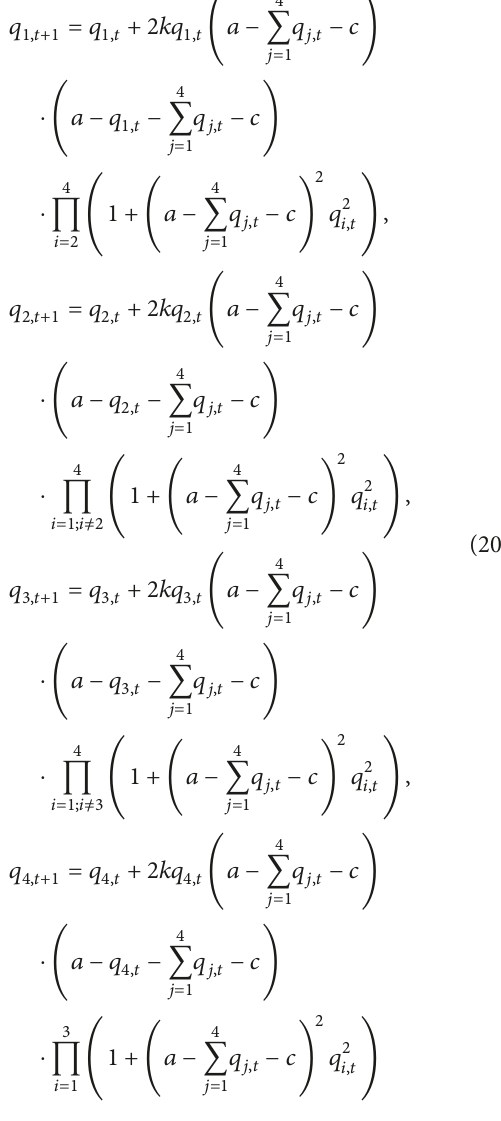
Figure 6: Bifurcation diagram of system (14) with respect to 𝑘 at (𝑎,𝑐,𝛼,𝑞 0.13, 0.11, 0.3, 0.4, 0.5, 0.6)